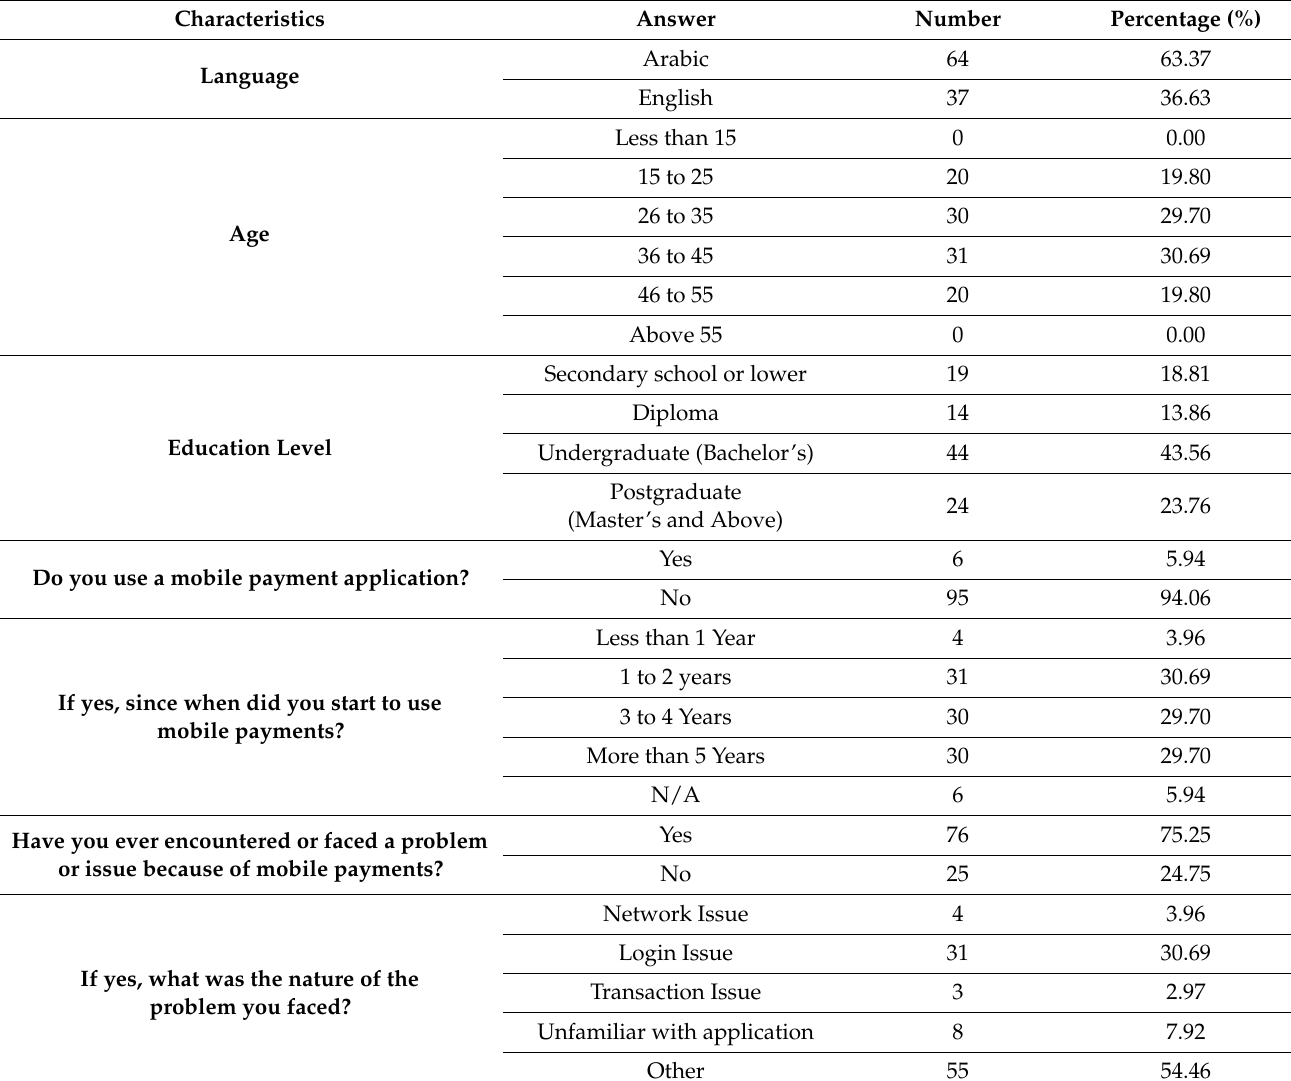
Table 1. Respondents’ demographic